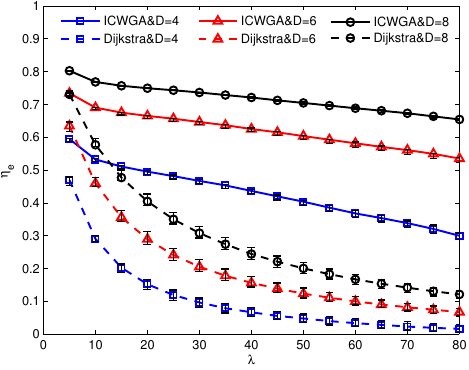
Figure 7. Energy saving of different link densities.